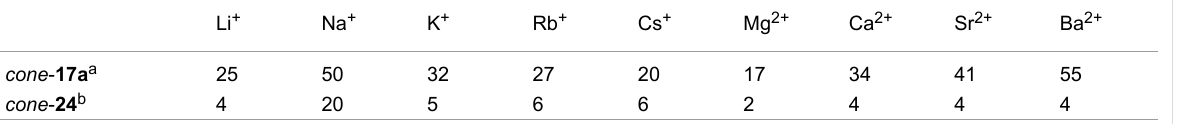
Table 3: Percentage extraction of alkali and alkaline earth metal picrates into CH 2 Cl 2 .